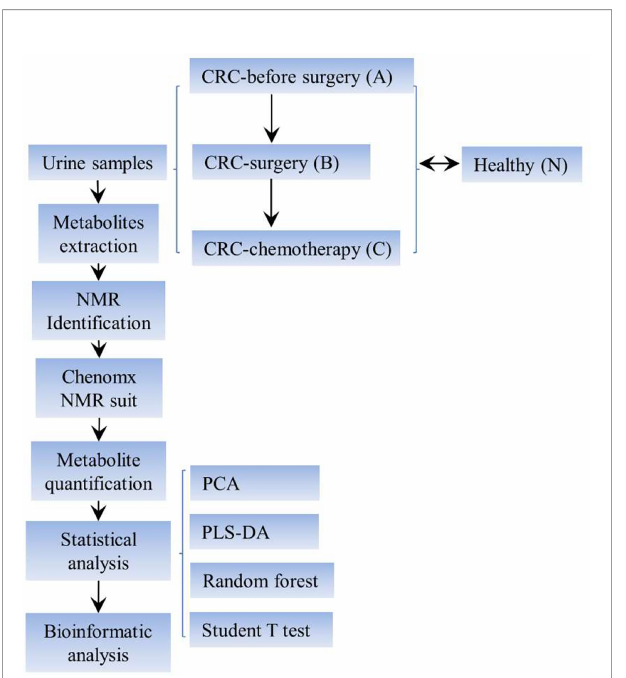
FIGURE 1 | Schematic view of the experimental setup of this study. CRC, colorectal cancer; NMR, nuclear magnetic resonance; PLS-DA, partial least squares discriminant analysis.